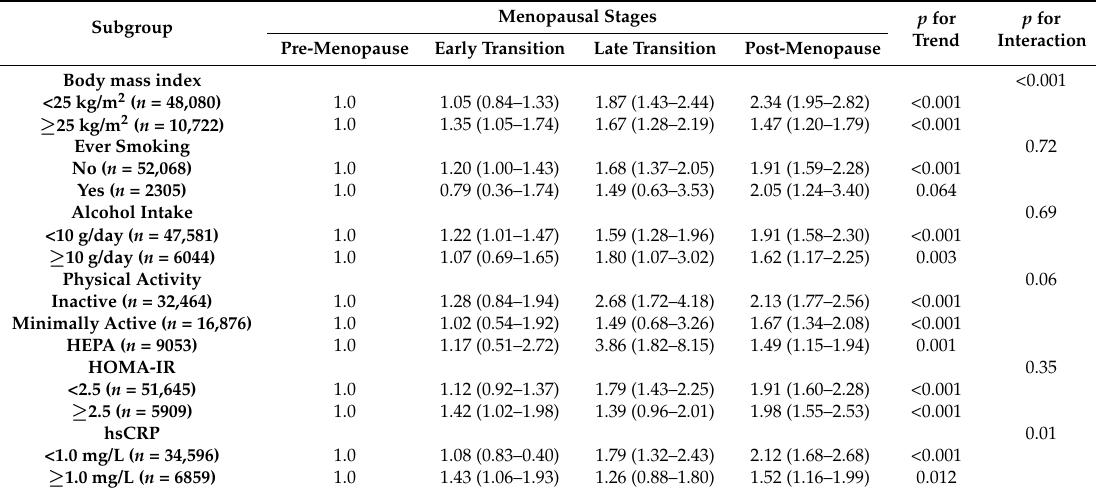
Table 4. Odds ratios a (95% Confidence intervals) of hyperuricemia by menopausal stage in clinically relevant